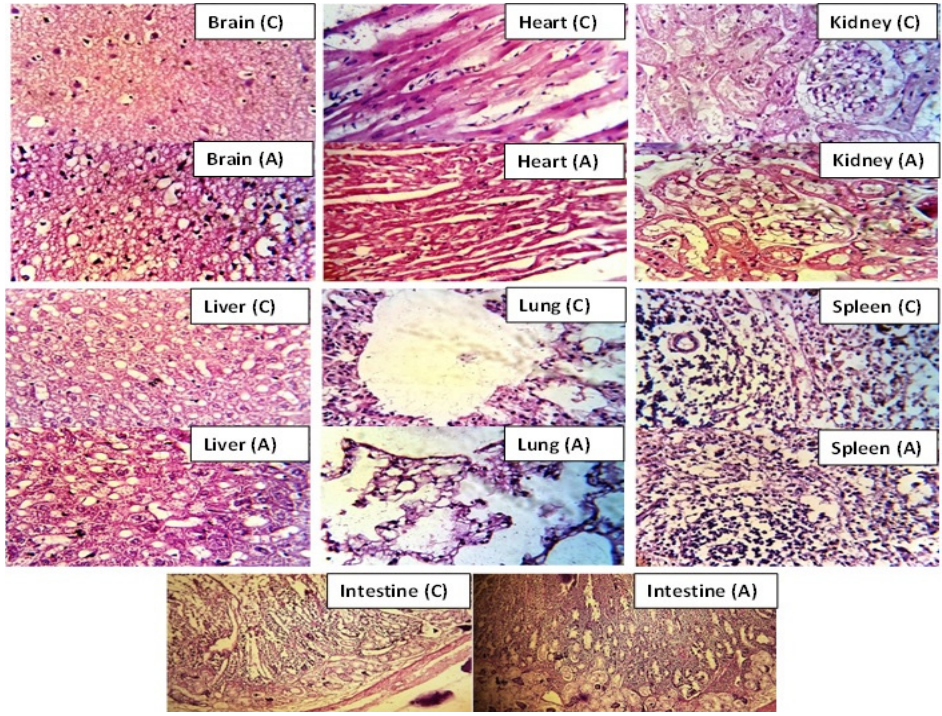
Figure 11. Histopathological images of vital organs of rabbit after administration of hydrogel network (2 g/kg) in control group (C ) and treated group (A) .